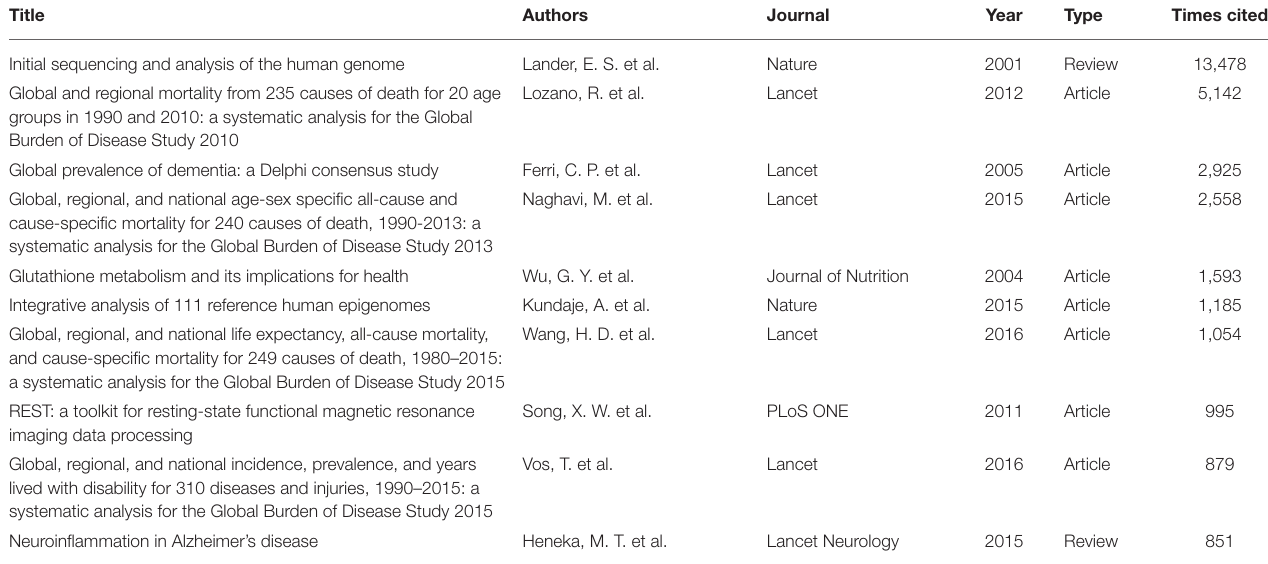
TABLE 2 | The top 10 most frequently cited papers on AD